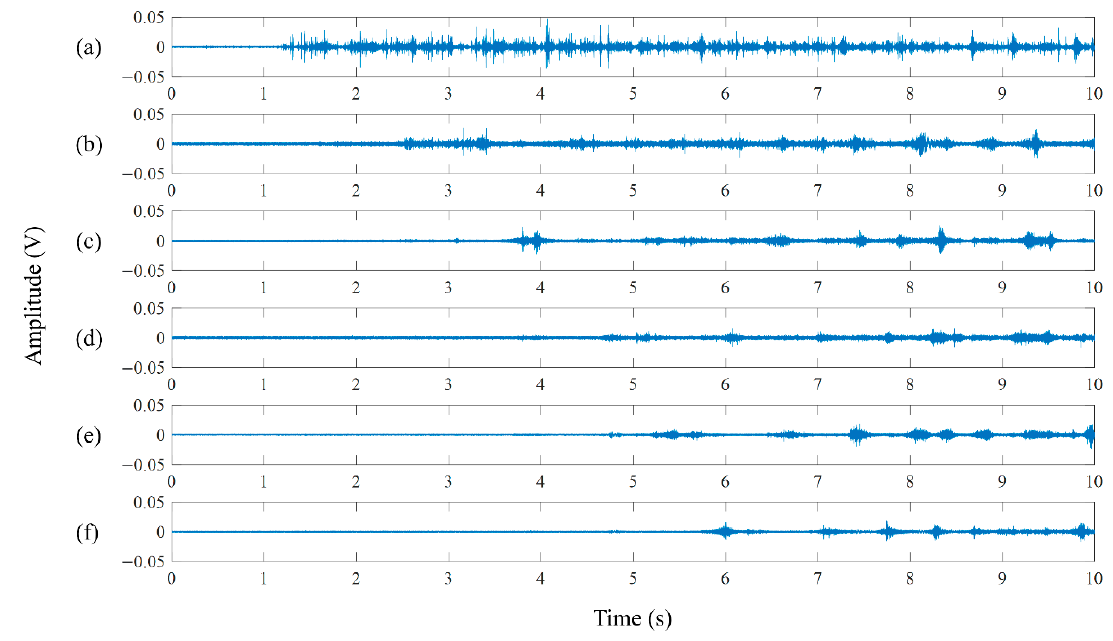
u = 0.09 m/s with u = 0.59 m/s. Figure 6. Vibration signals from accelerometers 1–6 in ( a – f ), respectively. The flow is generated at u SW SW SG